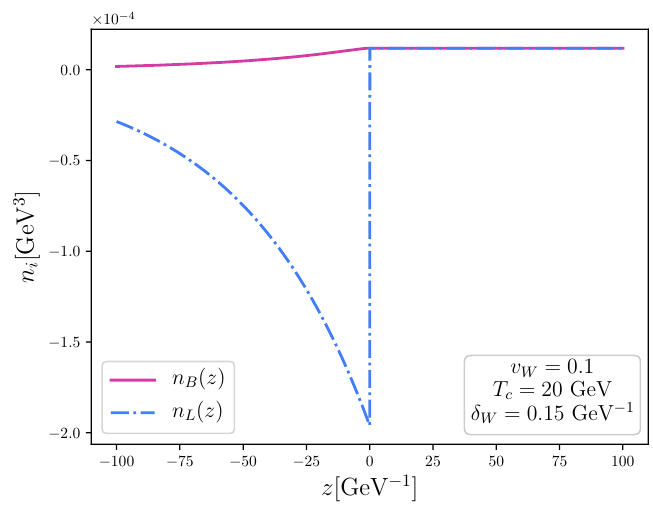
Figure 5 . Evolution of lepton and baryon number asymmetries as they transition from the sym- metric phase ( z ) to the broken phase ( z ). The masses of the heavy neutrinos in this ! (cid:0)1 ! 1 case are M 1 = 60 GeV, M 2 = 70 GeV and M 3 = 80 GeV while m D has been (cid:12)xed as discussed at the end of section 2. The heavy-active mixing has been set to Tr [ (cid:18)(cid:18) y ] = 0 : 045. The (cid:12)nal BAU found for this particular point is Y B Y obs = B (cid:24)